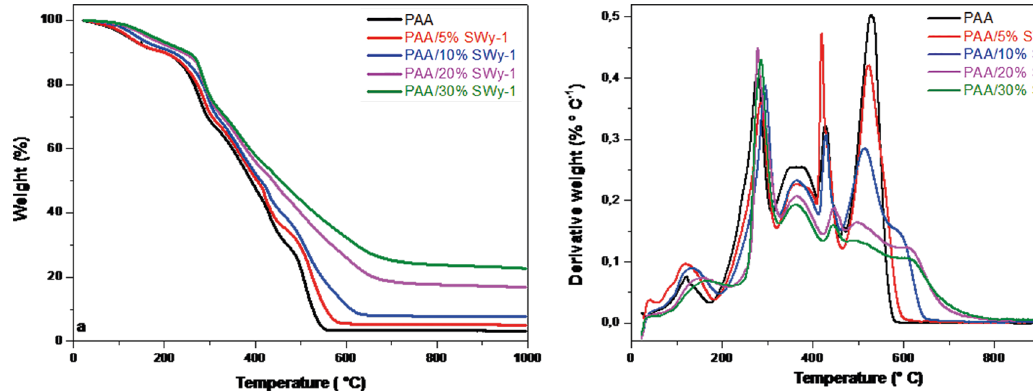
Figure 5. TGA and DTG curves for PAA and nanocomposite films.